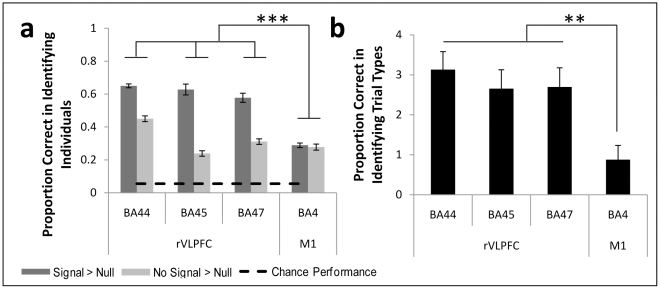
Multivariate pattern analysis reveals similar representations in the rVLPFC despite differing inhibitory demands.(A) rVLPFC was recruited in subject-specific but consistent ways regardless of stopping demands: individual differences in (Double) Go task hemodynamic activity also differentiated subjects in the Stop task. (B). rVLPFC showed trial-type-specific recruitment that was consistent across tasks, contradicting stopping-specific accounts of rVLPFC function. ** p<.0001 *** p<.005.